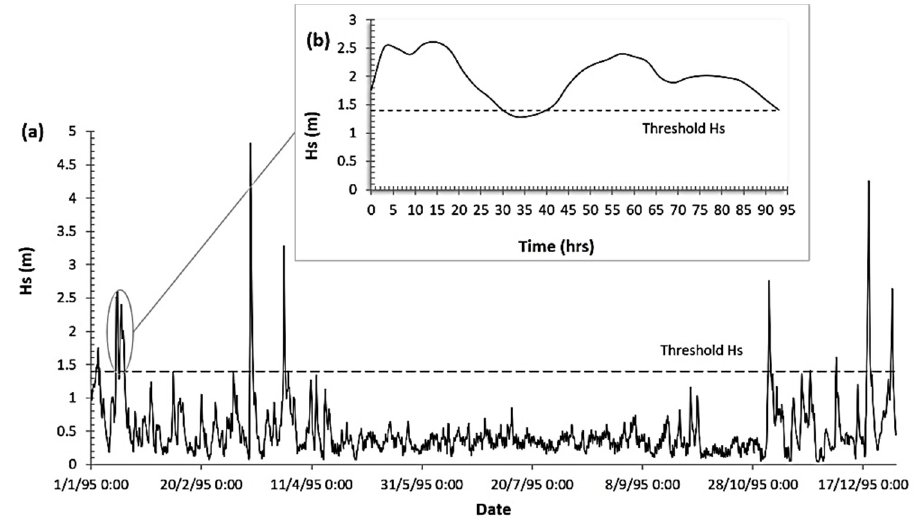
Figure 2. Time series of significant wave height (corresponding to the dataset of Atlas point P4) during ( a ) one year of the analysis (1995) and ( b ) a double-peaked storm event with Hs > 1.4 m (threshold), dt = 93 h, and inter-storm period = 9 h.